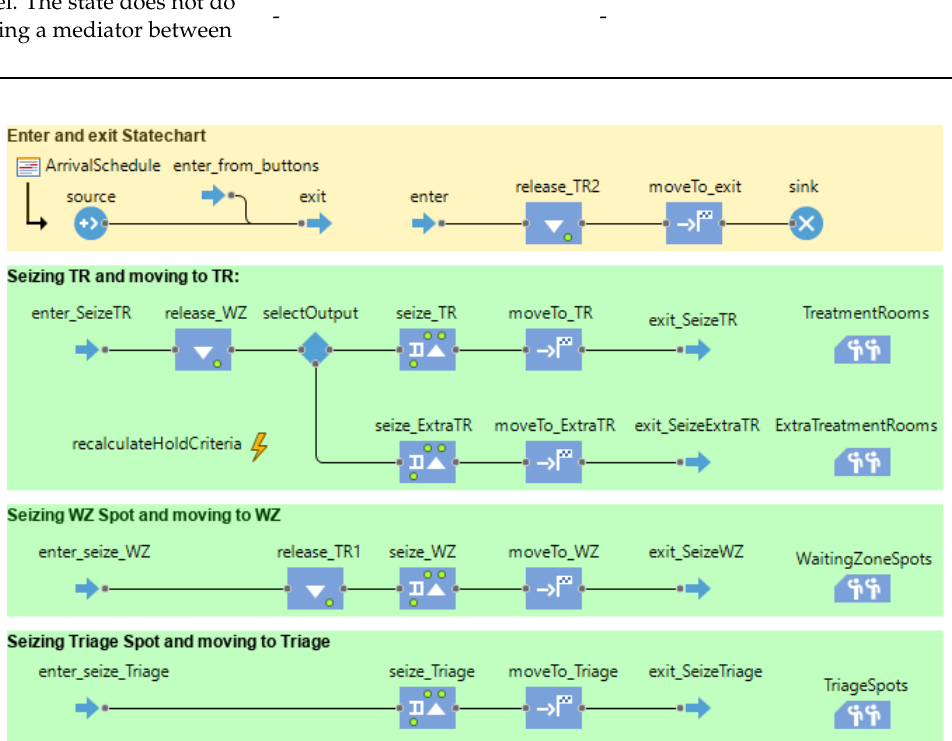
Figure 14. Process diagram programmatically carrying out the resource allocation. Patients are in- put in the source and output in the sink; resources will be seized and released depending on the individual patient agent’s situation.